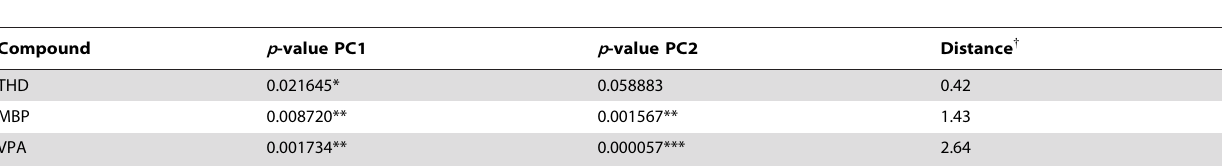
The comparisons were based on the coordinates (PC1 and PC2) of each sample on the PCA plot. { Distances from the center (average) of the exposed cultures to that of the